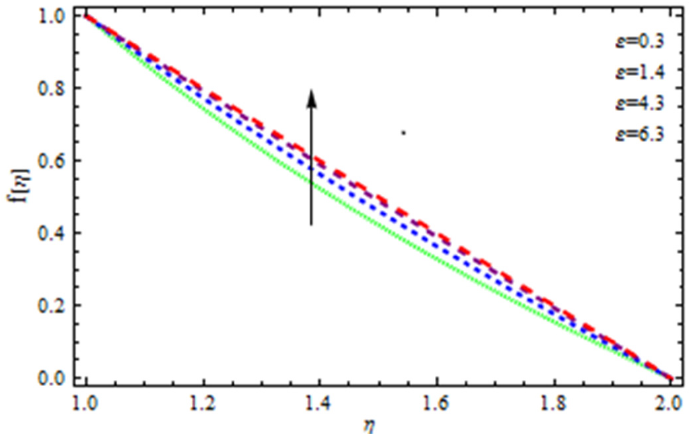
Figure 4. Influence of ε on the velocity curve.